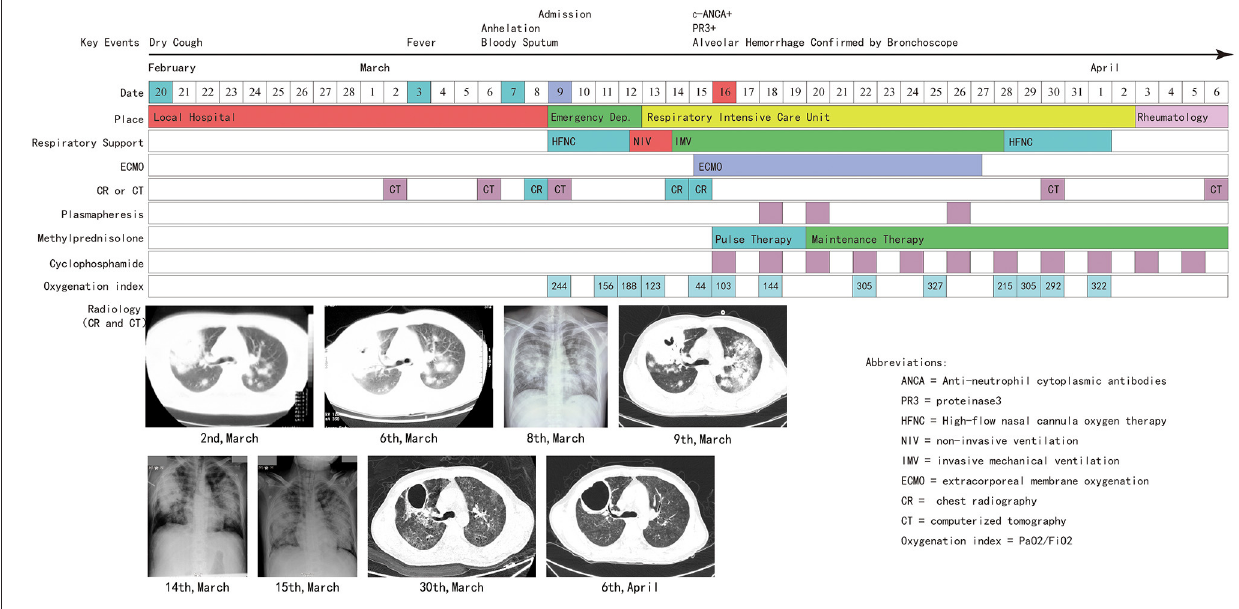
FIGURE 1 | Time-line of courses and